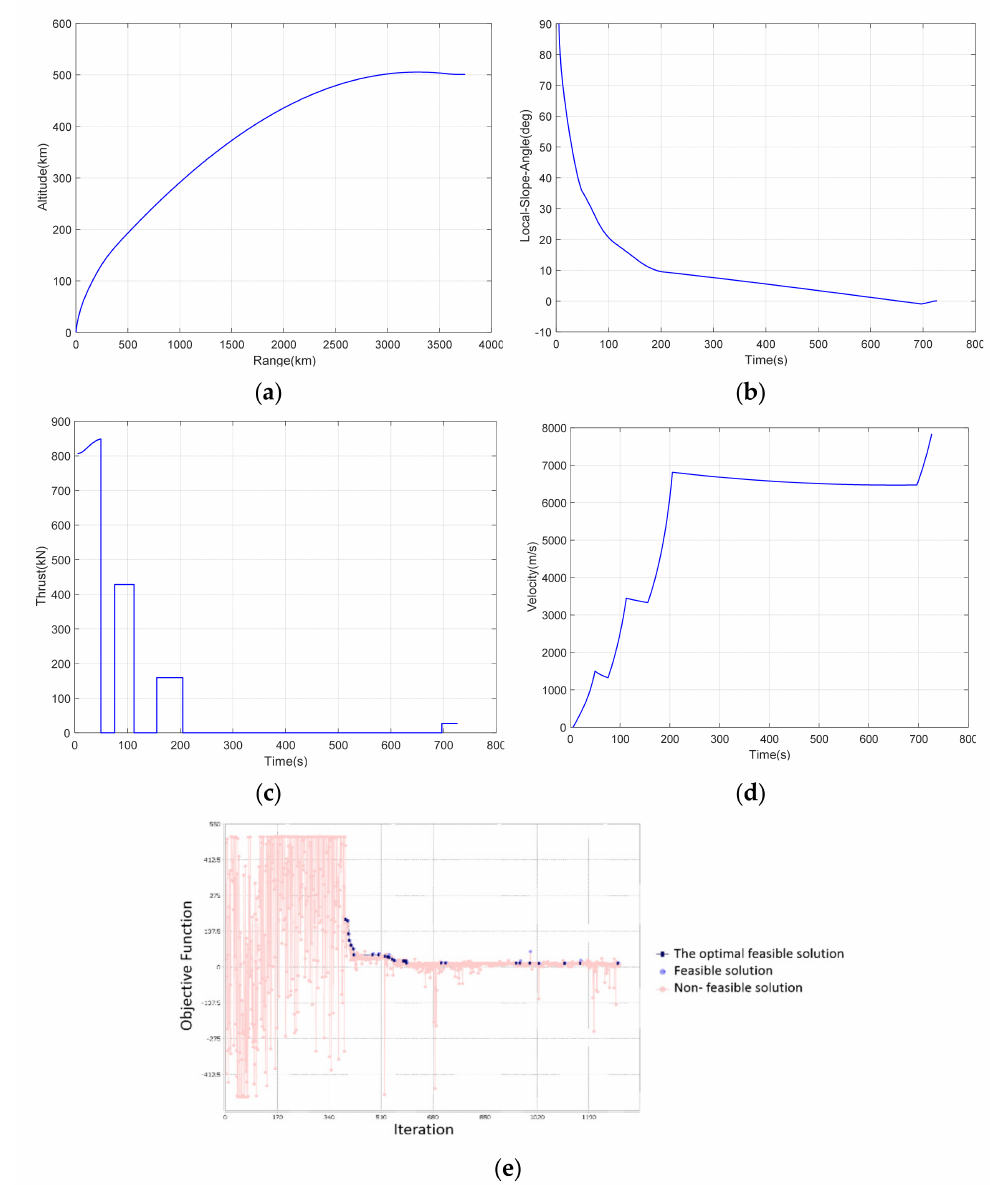
Figure 5. Optimization results for ground-launched rockets. ( a ) Range–height curve, ( b ) Time–local flight path angle curve, ( c ) Time–thrust curve, ( d ) Time–velocity number curve, ( e ) Convergence curve of the objective